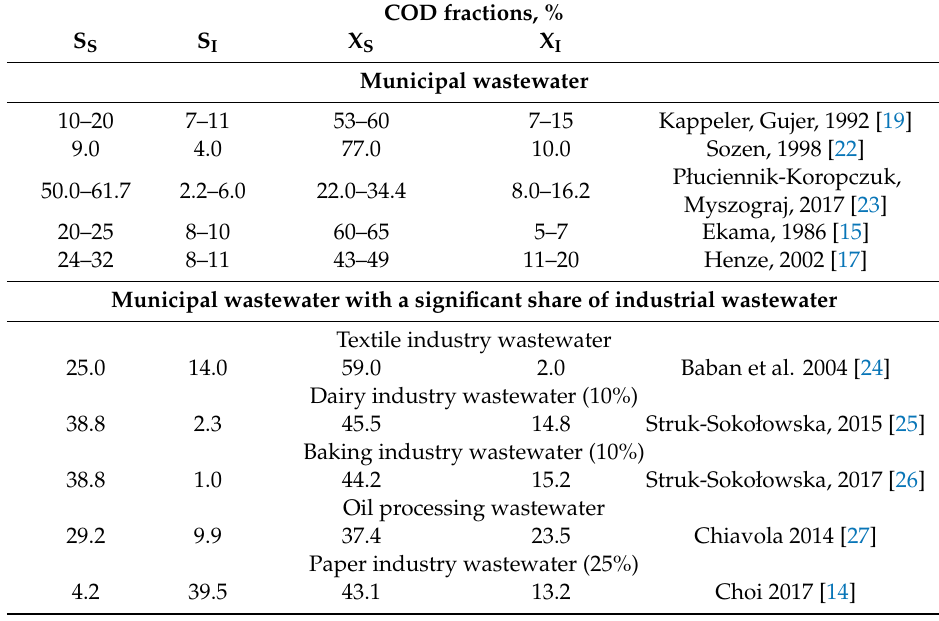
Table 2. Share of COD fraction in municipal raw wastewater and municipal wastewater with a significant share of industrial